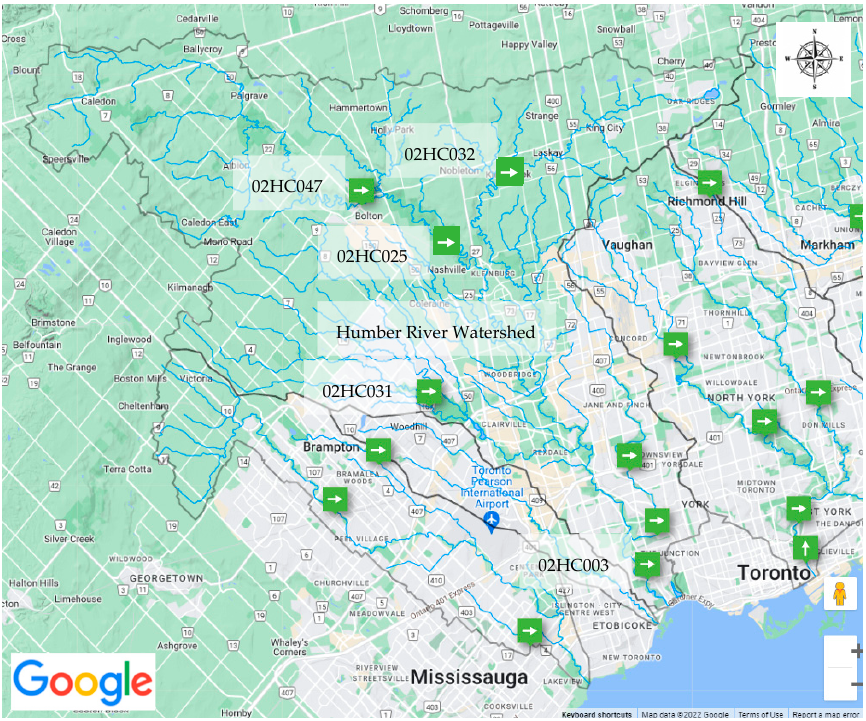
Figure 2. The network of real-time hydrometric monitoring stations in the Humber River Watershed. (Source: http://beta.trcagauging.ca/ accessed on 20 April 2022).